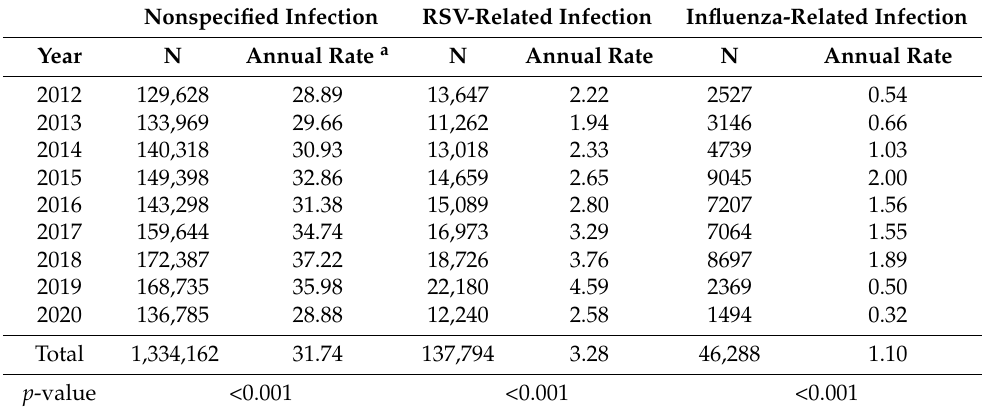
Table 2. The hospitalization rate in the general population in Spain by diagnostic group and year between 2012 and 2020.